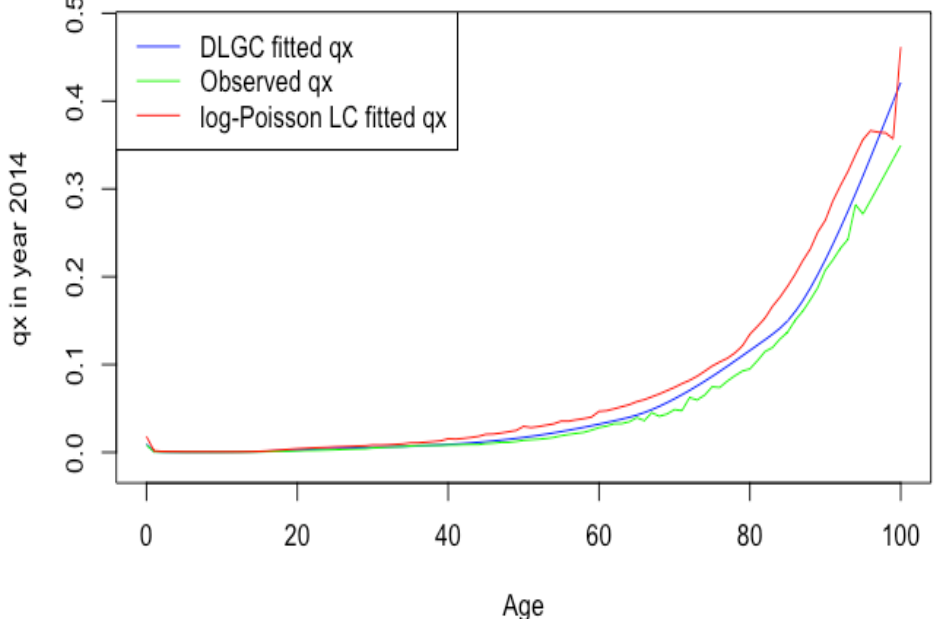
Figure 1. RUS male 2014 death rate forecasting of DLGC and the logit-binomial Lee–Carter model.